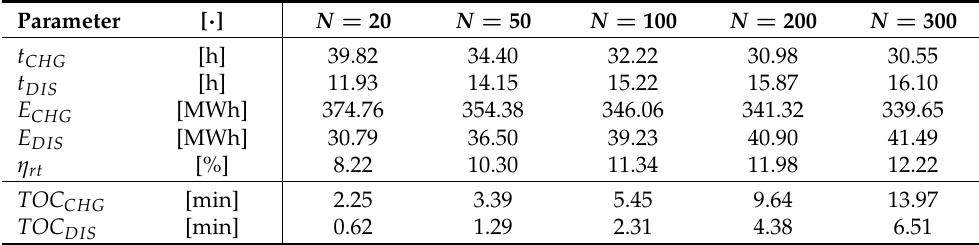
Figure A1. TES-PD model behaviour with increasingly refined grid level. Table A1. Performance parameters as function of the grid